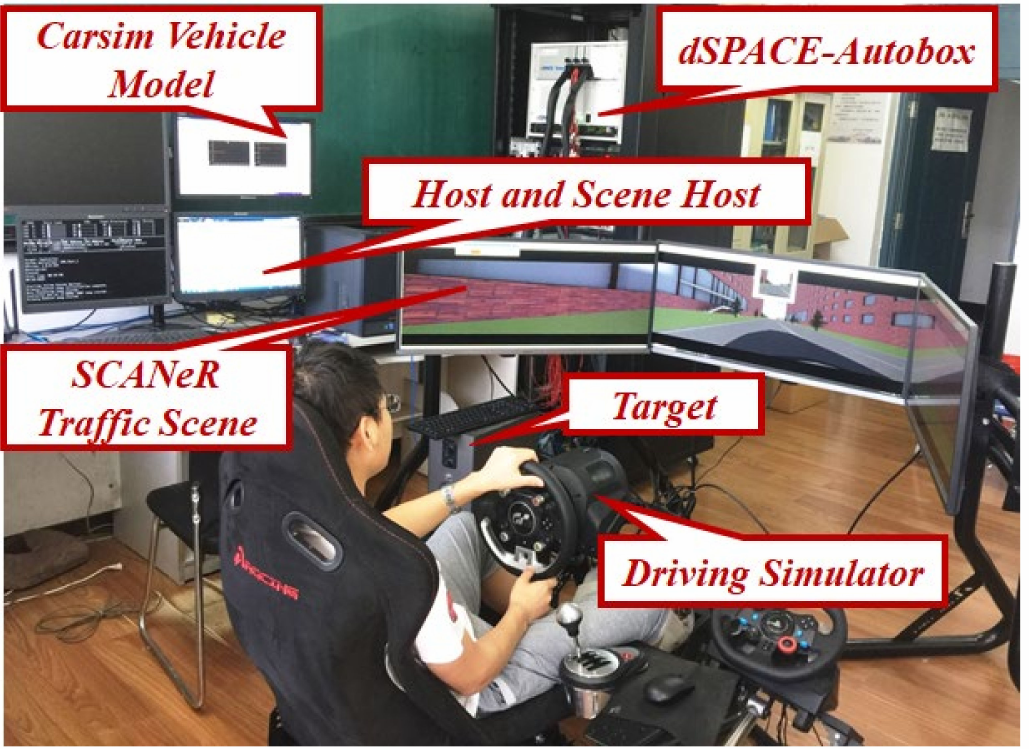
Figure 5. Experimental platform.